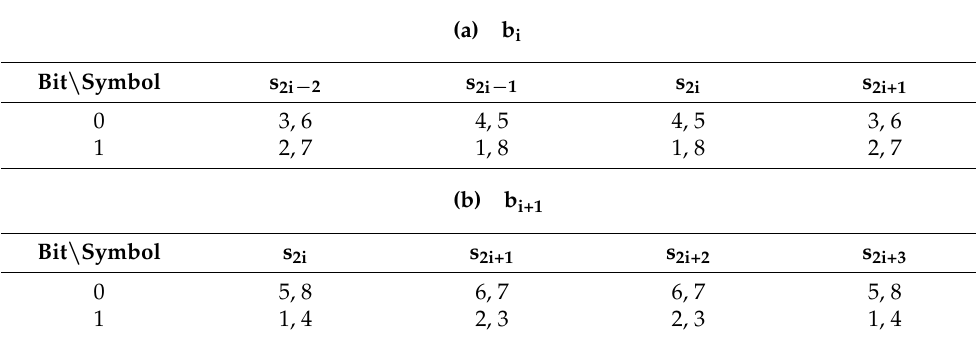
Table 5. Relationship between symbols and bits.